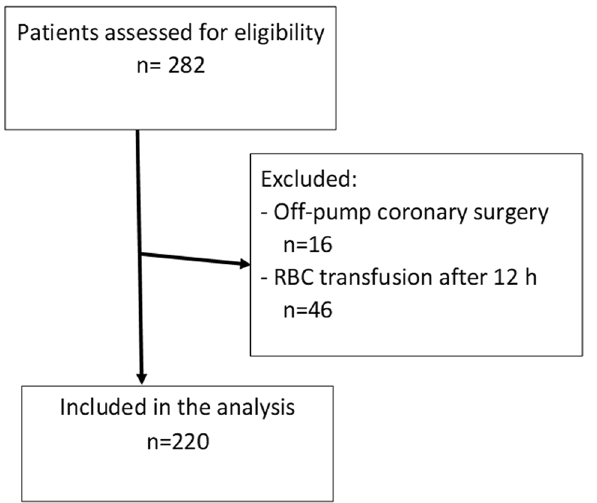
Figure 1. Flow chart of